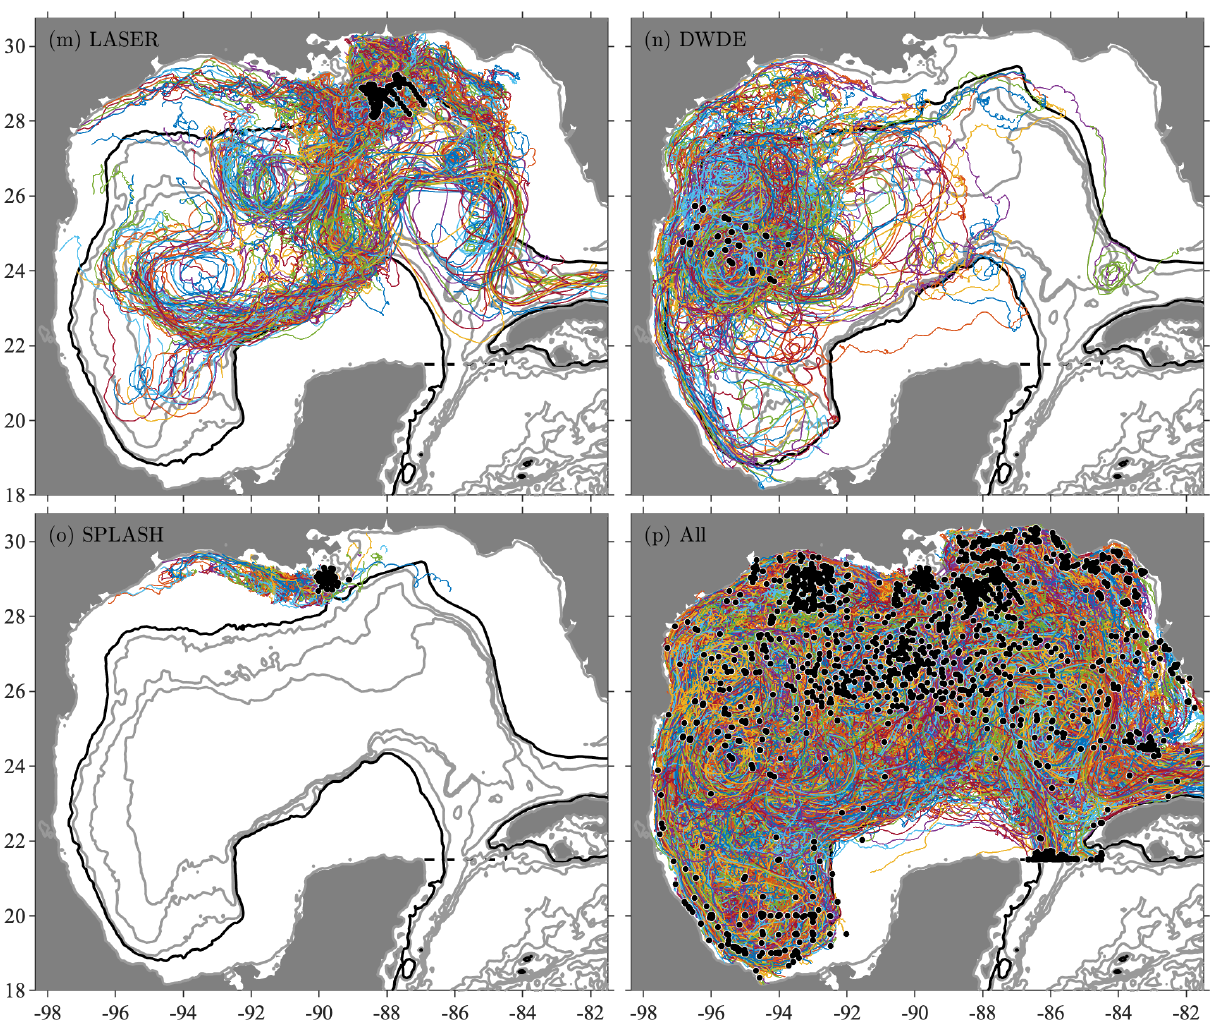
Figure 4. Surface drifter data in the Gulf of Mexico from 15 different sources, as labeled, together with the combined dataset in the last panel. Colored lines are different trajectories from the processed dataset, the beginning of each of which is marked by a black